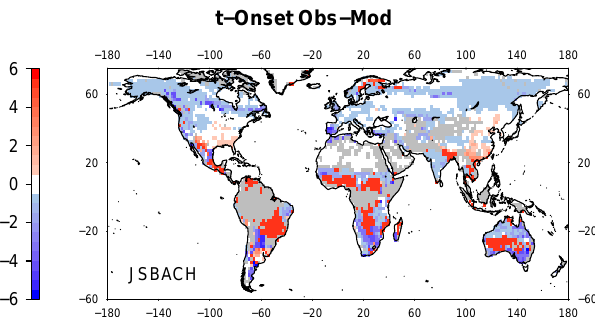
Fig. 4. Difference between the most frequent month of time of onset for SeaWiFS-FAPAR data and modelled FAPAR (expressed as months) during 1998–2005. Grey areas were masked out from the analysis and indicate missing observations, dominance of trop- ical evergreen rain-forests, desert or glaciers, or areas with more than one growing season. Red cells indicate missing data from the model.